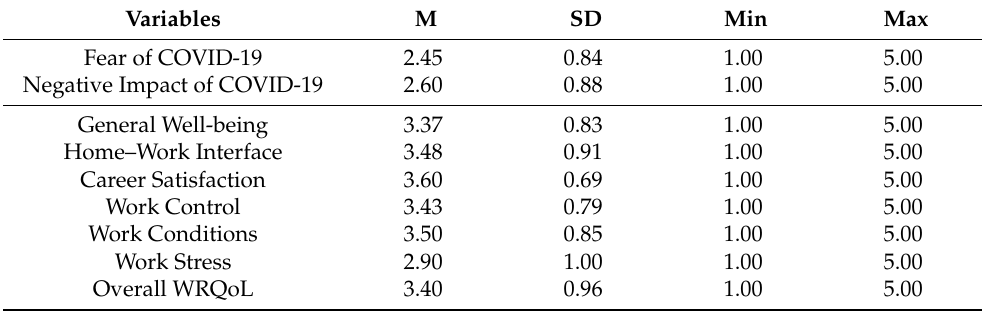
Table 2. Overall results for the fear of COVID-19, negative impact of COVID-19, and WRQoL.